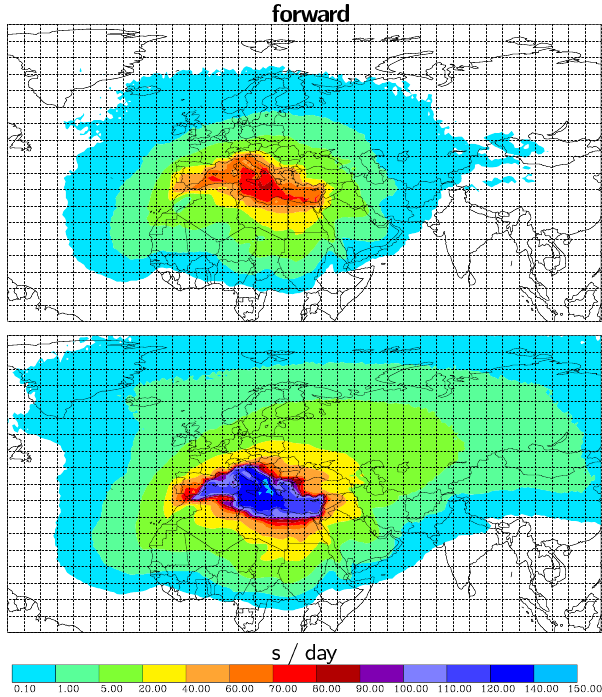
Fig. 3. Five-day residence